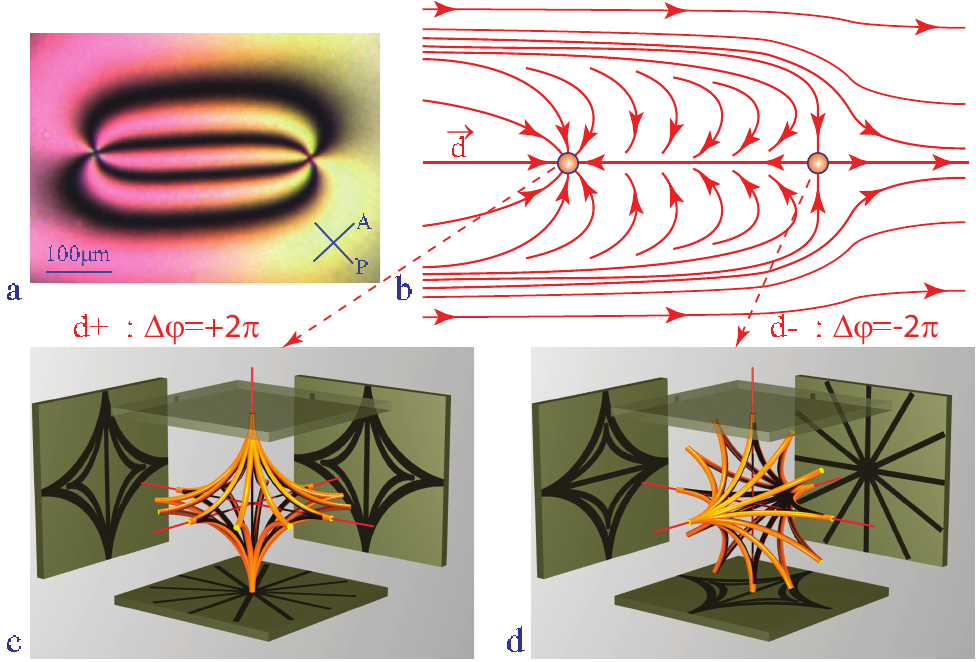
Figure 3. Pair of dowsons, topological defects of the dowser field d . ( a ) View in polarising microscope. ( b ) The dowser field d (x,y) inferred from ( a ). ( c , d ) Monopoles in the 3D director field corresponding to the dowsons d+ and